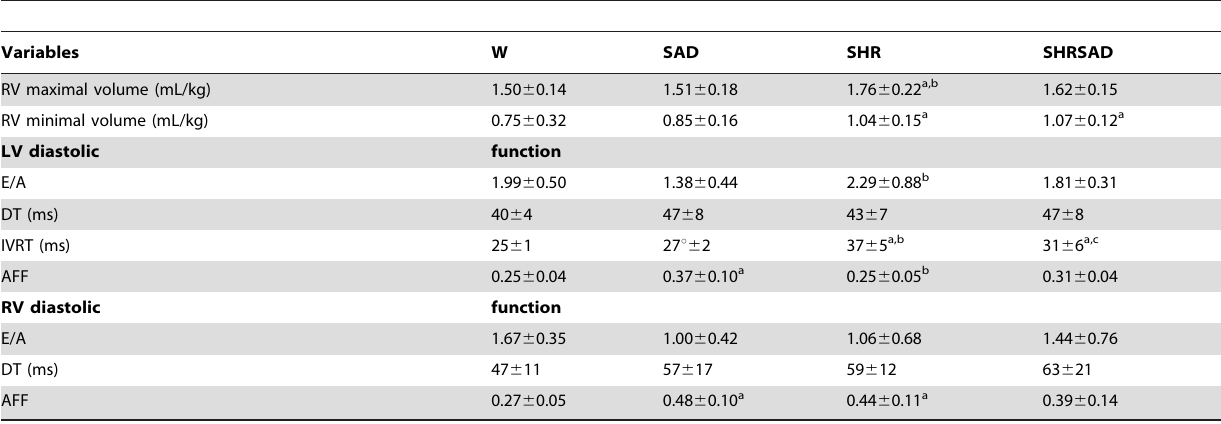
Table 2. Volumes and ejection fraction of the right ventricle, and biventricular diastolic function data obtained by transesophageal echocardiography.